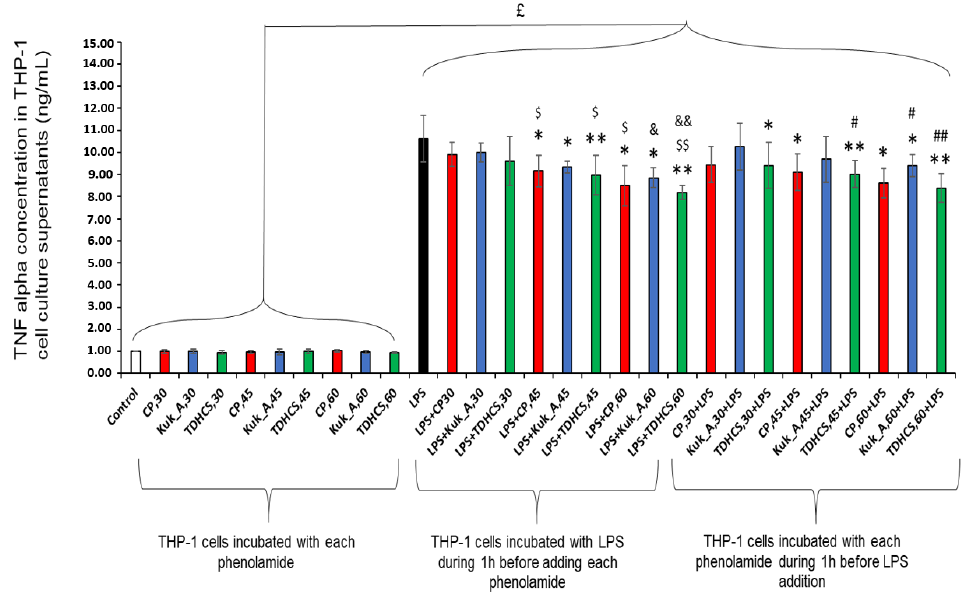
Figure 4. CP, Kuk_A and TDHCS are able to reduce the production of TNF- α induced by LPS in differentiated THP-1 cells. The three phenolamides were used at 30, 45 and 60 µM. Differentiated THP-1 cells were incubated for 24 h either with these molecules alone or with 100 ng/mL of LPS added one hour before or after the phenolamide addition. Cell culture supernatants were then collected and used to quantify TNF- α production by ELISA. This figure is representative of six independent experiments performed in triplicates. “Control” corresponds to a THP-1 cell culture in which no product was added (negative control). “LPS” corresponds to a THP-1 cell culture in which only LPS was added (positive control). “LPS + phenolamide, 30” indicates that LPS was added before phenolamide at a concentration of 30 µM while “phenolamide, 30 + LPS’ indicated that phenolamide at 30 µM was added before LPS. Data are presented as the mean ± S.D. t-tests were used to identify statistically significant differences. £ p < 0.05 vs. conditions without LPS; * p < 0.05, ** p < 0.01 vs.